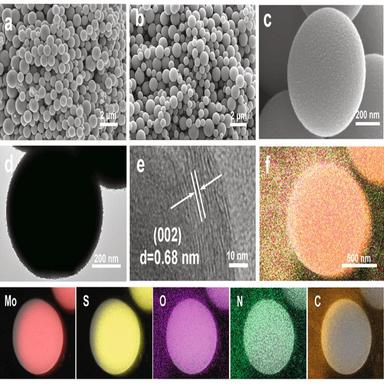
(a) FESEM image of precursor, (b, c) FESEM images, (d) TEM and (e) HRTEM images, and (f) FESEM elemental mappings of Mo, S, N ,O and C for 1 T-MoS2/MoOx@NC.